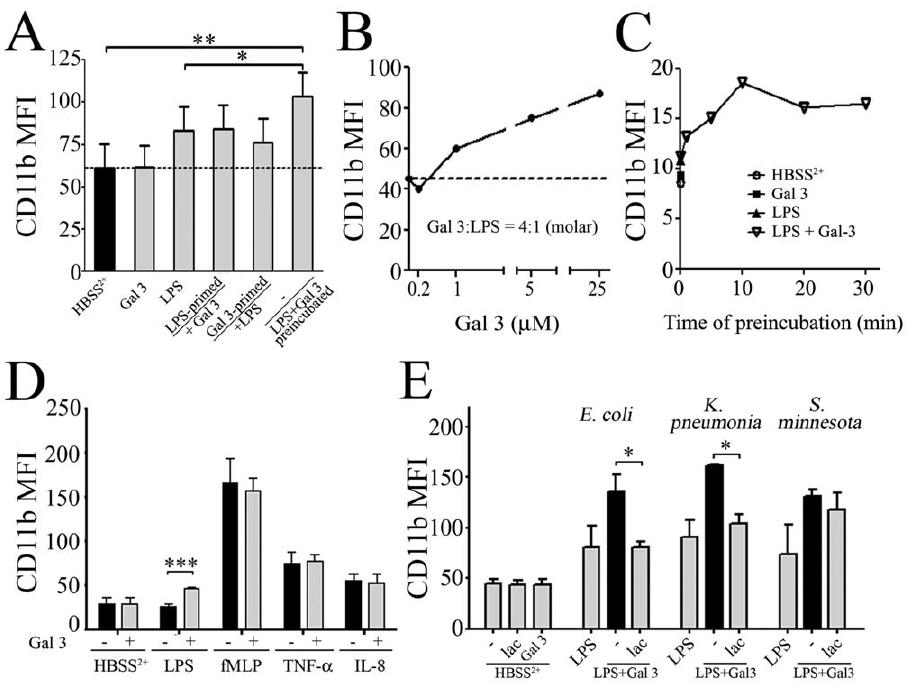
Figure 3. Gal 3 specifically enhances LPS-mediated neutrophil activation and requires a direct interaction with LPS for its effect. A : PMNs were primed for 30 min at 37 u C with Gal 3 (0.2 m M) or E. coli LPS (1 m g/mL) and then stimulated with LPS (1 m g/mL) or Gal 3 (0.2 m M), respectively. Alternatively, Gal 3 (1 m M) and LPS (5 m g/mL) were preincubated together for 30 min at 37 u C and then diluted to 0.2 m M (Gal 3) and 1 m g/mL (LPS) to be used to stimulate PMNs (n=2). B : Effect of increasing LPS and Gal 3 concentrations in the pre-incubation mixture. Increasing concentrations of Gal 3 (0.2 m M to 25 m M) and LPS (1 m g/mL to 125 m g/mL) were preincubated together for 30 min at 37 u C. They were then diluted in HBSS 2 + to the final Gal 3 2 0.2 m M and LPS – 1 m g/ml concentrations and added to PMN for a 45-min incubation at 37 u C. C : Time-response curve of LPS and Gal 3 preincubation. Gal 3 (7 m M) and LPS (35 m g/mL) were preincubated together for 0–30 min, as indicated, at 37 u C and then diluted to 0.2 m M (Gal 3) and 1 m g/mL (LPS) to be used to stimulate PMNs for a 45-min incubation at 37 u C (representative from 2 independent experiments). D : PMNs were stimulated with LPS (1 m g/ml), fMLP (10 2 6 M), TNF- a (10 ng/ml) or IL-8 (25 ng/ml), which had all been preincubated without (black) or with Gal 3 (0.4 m M, grey) for 30 min at 37 u C. Neutrophil CD11b expression was measured as in figure 1 (n=5). E : Gal 3 effect on neutrophil activation by LPS from various strains of bacteria. Gal 3 (1 m M) was preincubated with 10 m g/ml LPS from E. coli , K. pneumonia or S. minnesota R7 for 30 min at 37 u C, in presence or absence of 10 mM lactose (lac). Then, each mixture was diluted to 0.2 m M (Gal 3) and 1 m g/mL (LPS) concentrations and used to stimulate PMNs (2 6 10 6 /mL) for 45 min at 37 u C, and analyzed for CD11b expression as above. Results are expressed as mean fluorescence intensity (MFI) (n=3). * p , 0.05, **p , 0.01, ***p ,